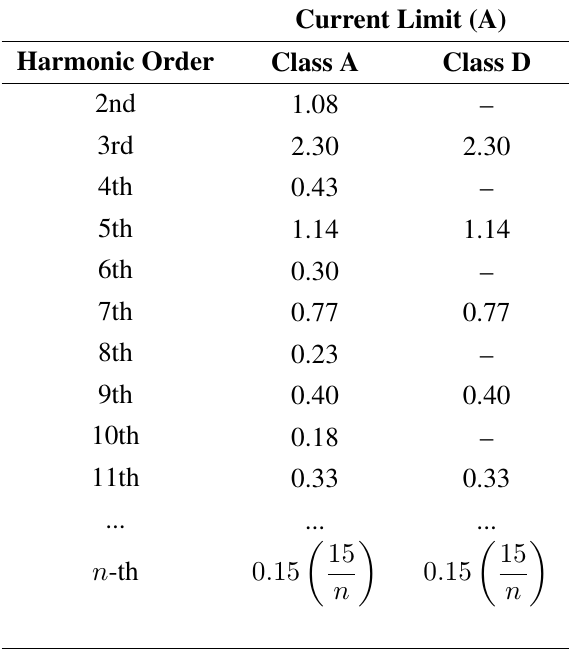
Table 3. EN61000-3-2 current harmonic limits for two classes of household appliances. Class A appliances are household appliances up to 16 A, and Class D appliances are electronic appliances that are rated less than 600 W. The limits for the even harmonics of Class D appliances are not specified by the